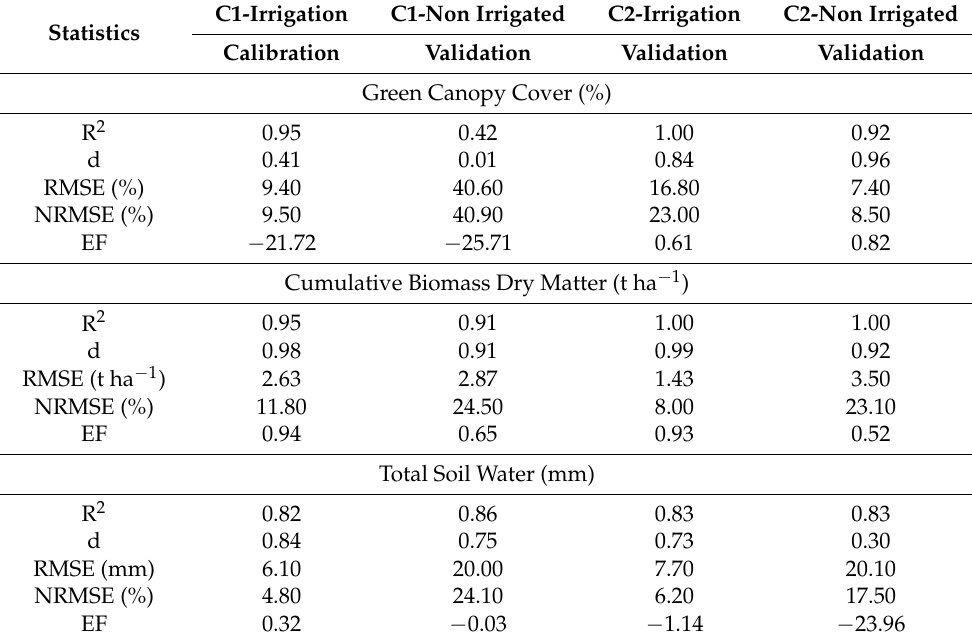
Table 7. Statistical evaluation parameters and values for green canopy cover, cumulative biomass dry matter, and soil water, for calibration and validation treatments of ryegrass ( Lolium perenen